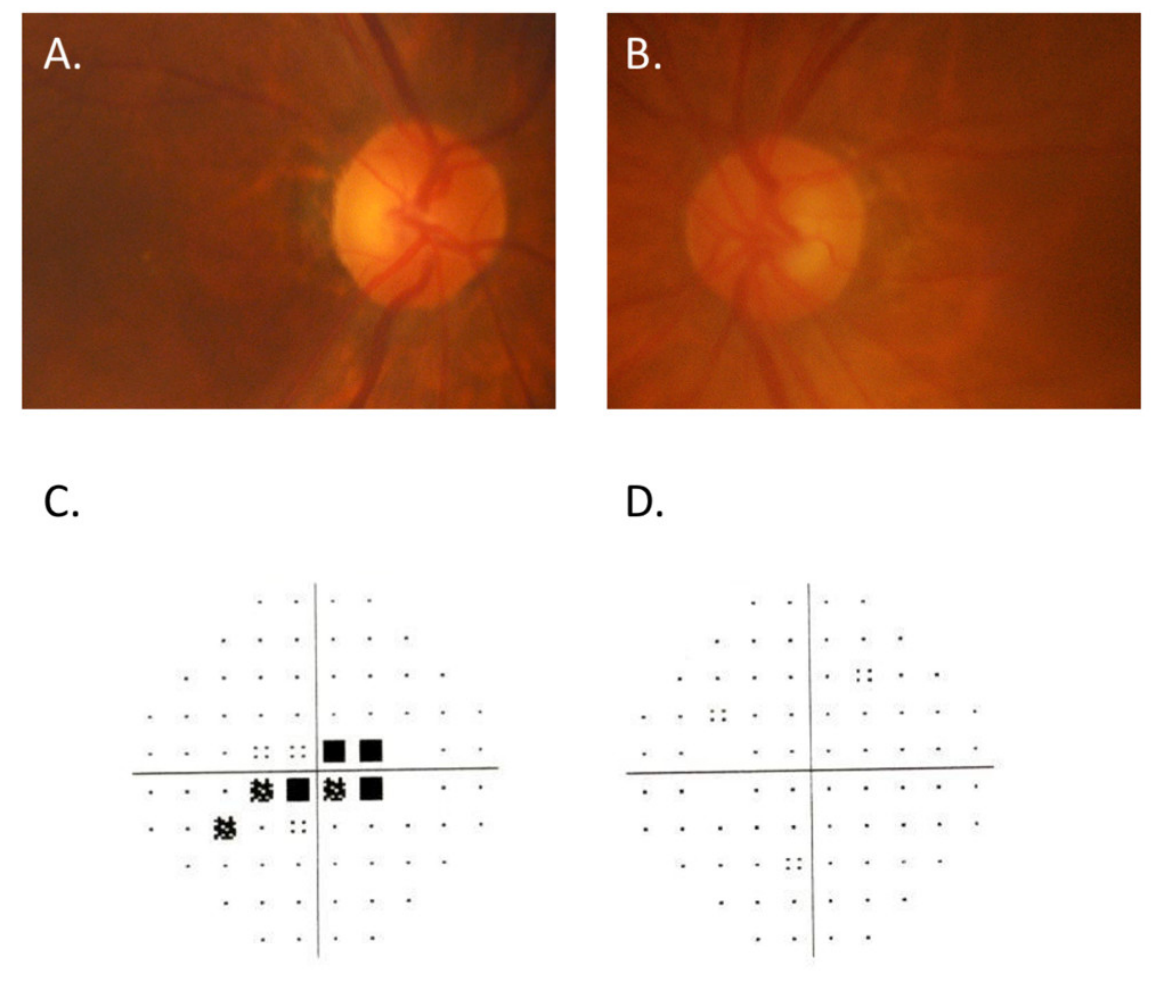
Figure 3. ( A , B ) color fundus photographs of the right eye ( A ) and left eye ( B ) 1 month after receiving the second COVID-19 vaccination. ( C , D ) Humphrey’s visual field analysis of the right eye ( C ) and left eye ( D ).